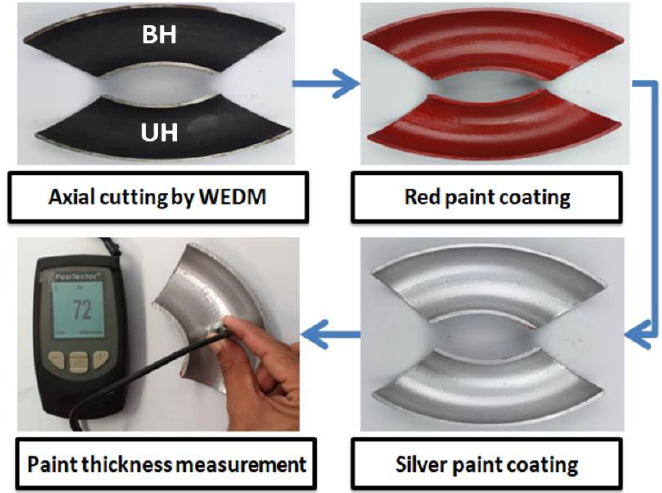
Figure 4. Multilayer paint modeling (MPM) sample preparation stages.